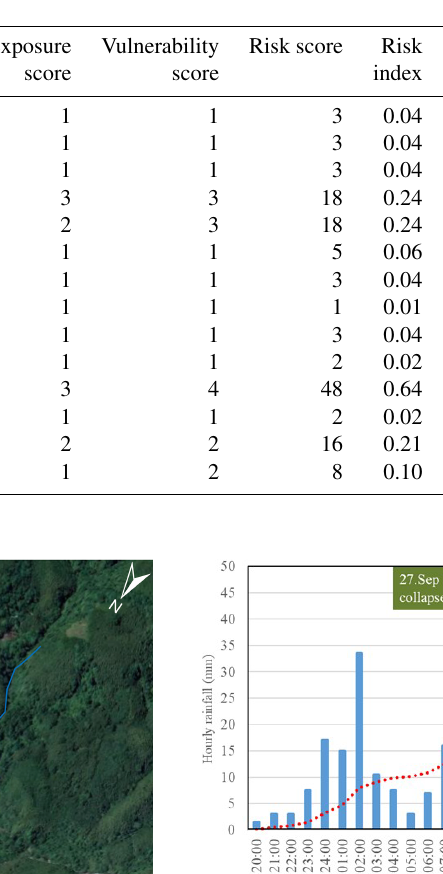
Table 18. Risk levels of slope units around the Neikuihui tribe.